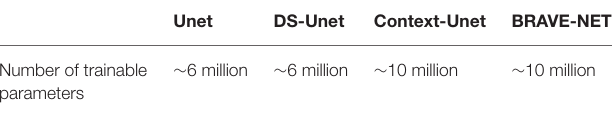
TABLE 2 | Number of trainable parameters of all implemented